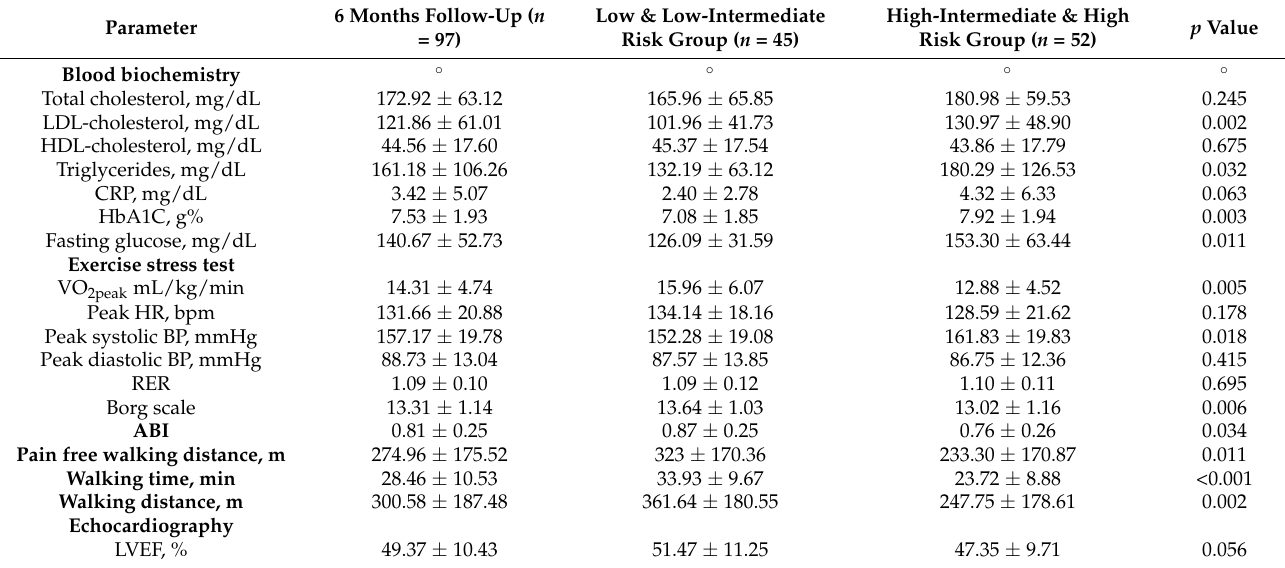
Table 5. Blood biochemistry and exercise stress test